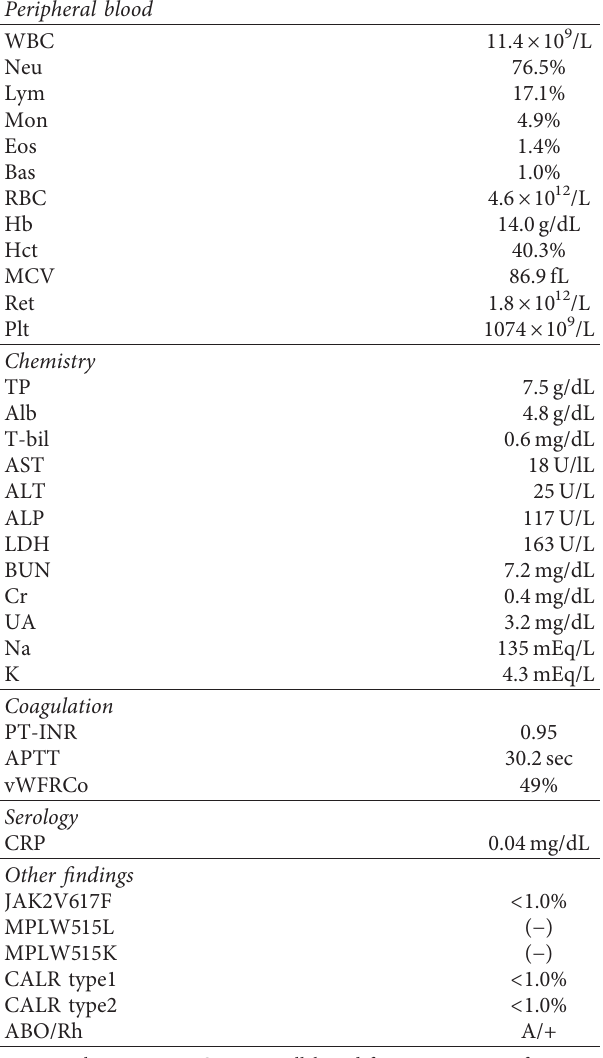
Table 1: Laboratory findings on